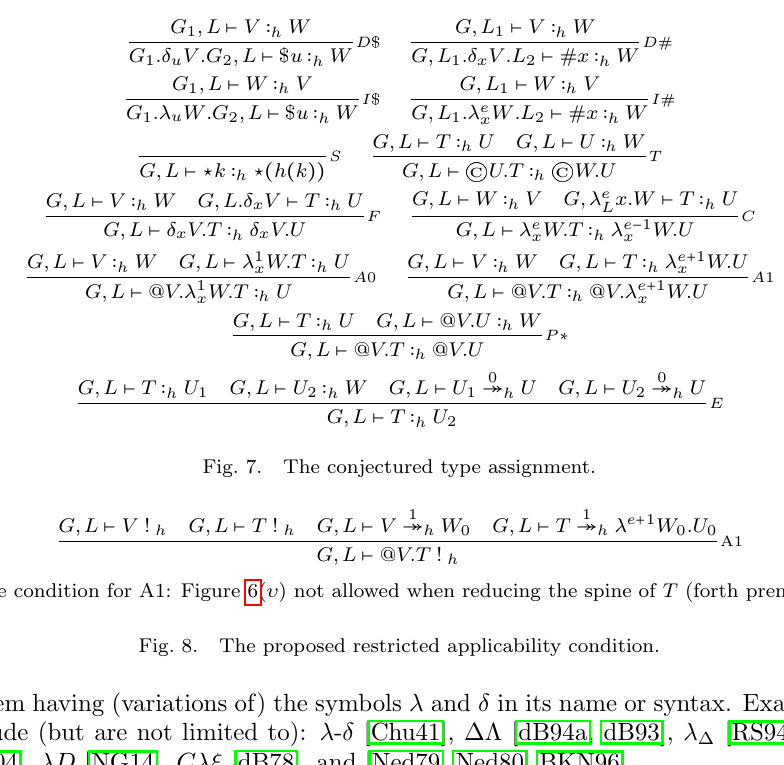
Fig. 6. The proposed validity of terms and global environments.